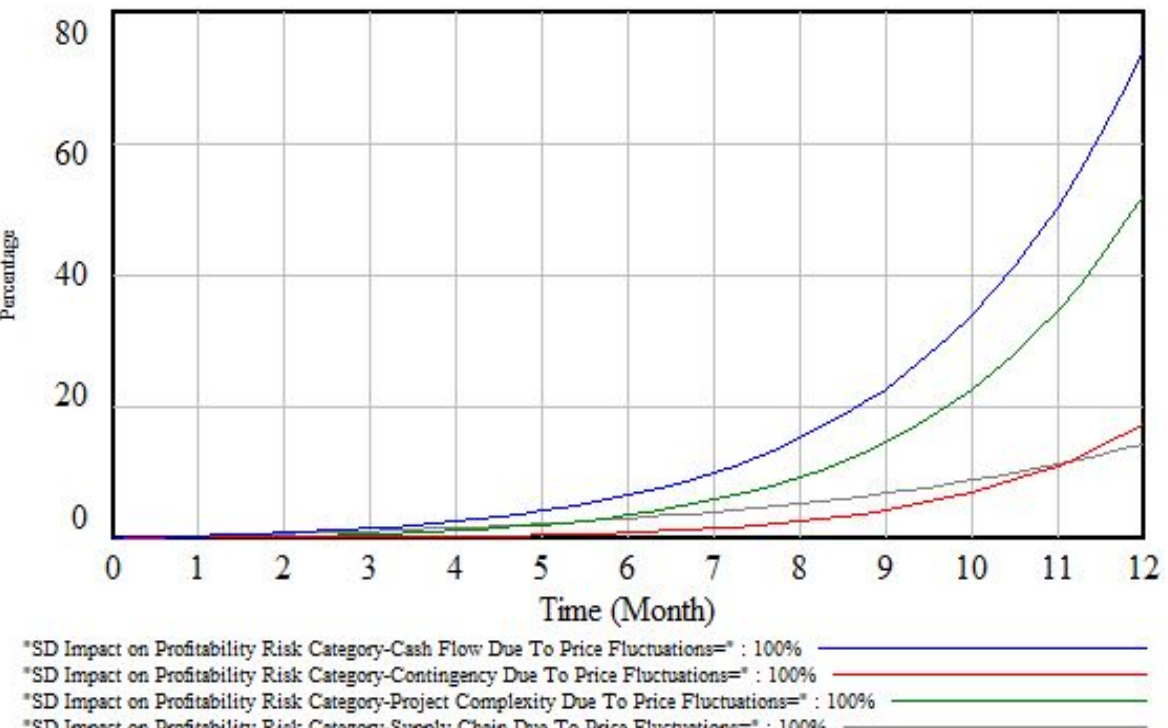
Figure 12. Dynamic integrated impacts on profitability risk categories over time (price fluctuations =100%).